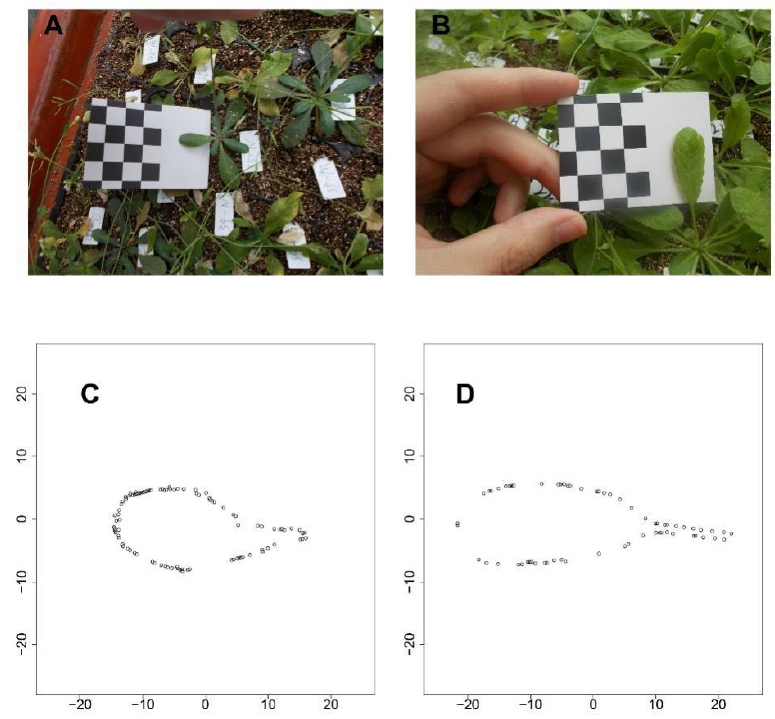
Figure 1. Effect with the shape reconstruction procedure. ( A , B ) are the original images taken by a digital camera, ( C , D ) are the reconstructed shapes manifested in coordinate systems.